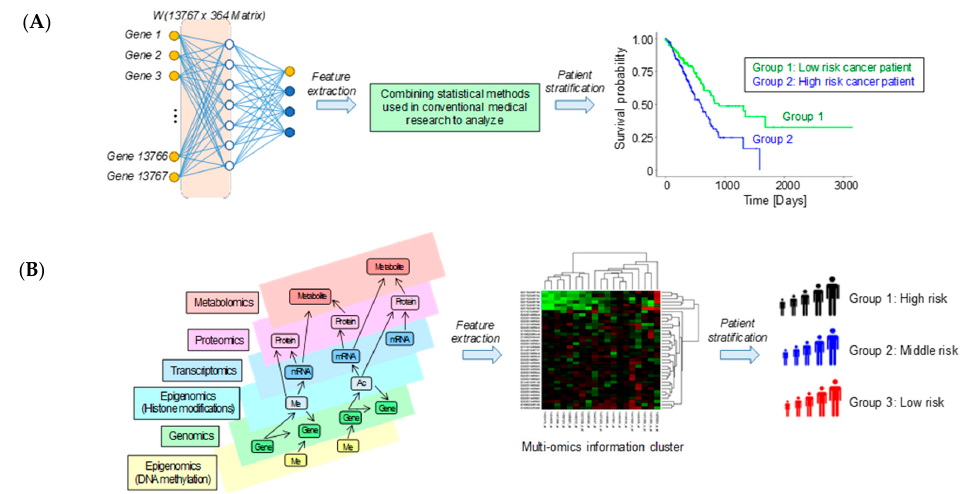
Figure 2. Examples of how machine learning and deep learning techniques are being used to reduce the dimensionality of massive omics data to extract features and then stratify the patients. ( A ) An example of analysis using Kaplan–Meier curves after dimensionality reduction and feature concentration using machine learning and deep learning techniques applied to genetic mutation information. ( B ) An example of patient stratification using machine learning techniques to extract features from multilayer omics data.